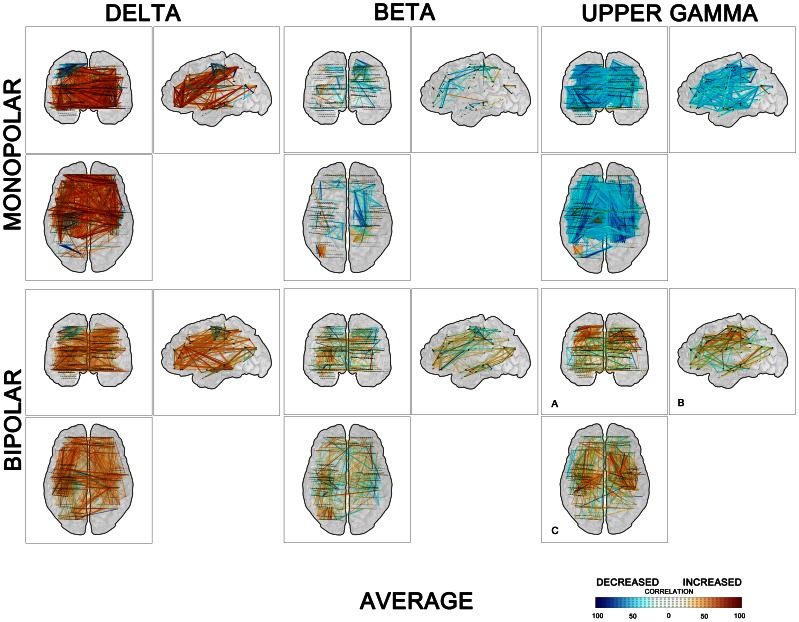
Spatial distribution of couplings/decouplings across all investigated subjects, in the time window 250–750 ms after targets.Three orthogonal views of a transparent “glass brain”; links are colored according to the percentage of duration of the increase (red) or decrease (blue) in cross-correlations within time window 250–750 ms after stimulation. Three selected frequency bands – δ (left panel), β (middle panel), and upper γ (right panel).